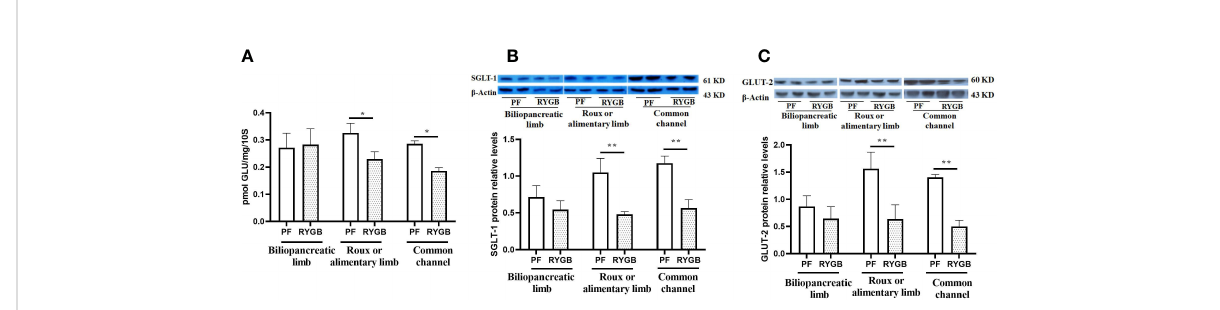
FIGURE 4 Effect of RYGB on the BBMV glucose transport and glucose transporter proteins of SGLT1 and GLUT2. On POD 21 segments from the biliopancreatic limb (BP), Roux limb and common channel (CC) were harvested from RYGB rats along with corresponding segments from PF rats. BBMVs were isolated and glucose uptake (A) was measured by rapid mixing uptake as described in the materials and methods. Glucose transporter proteins of SGLT1 (B) and GLUT2 (C) were examined by Western Blot. Data are mean ± SE, n=5-8 per group, *p<0.05, **